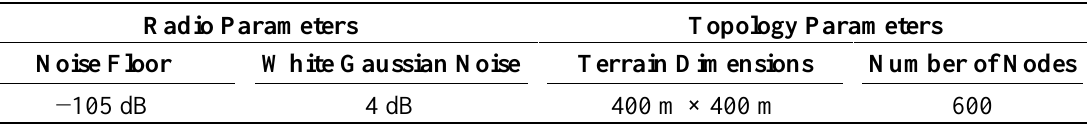
Table 2. Simulation